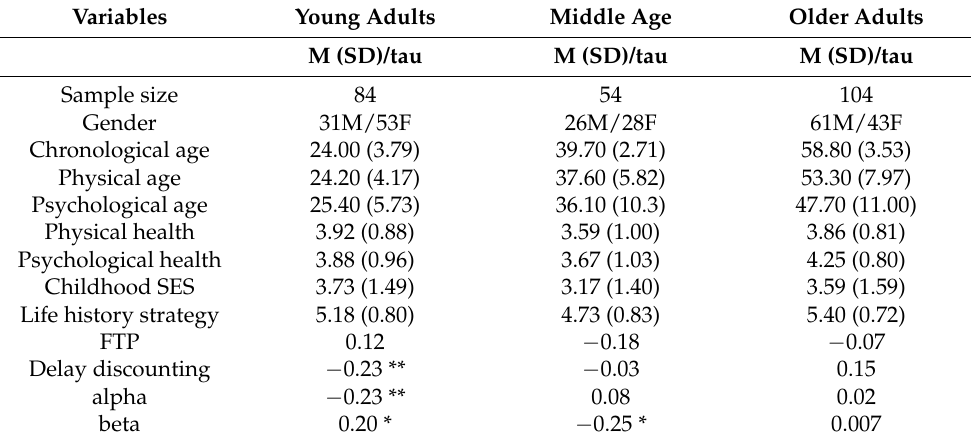
Table 1. Participant